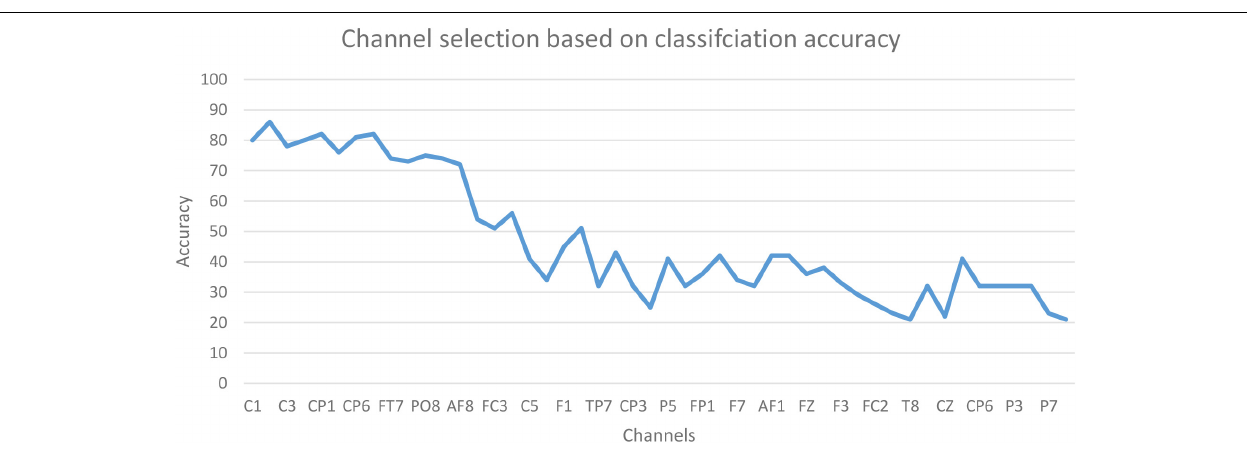
FIGURE 5 | The accuracy based on EEG channels.